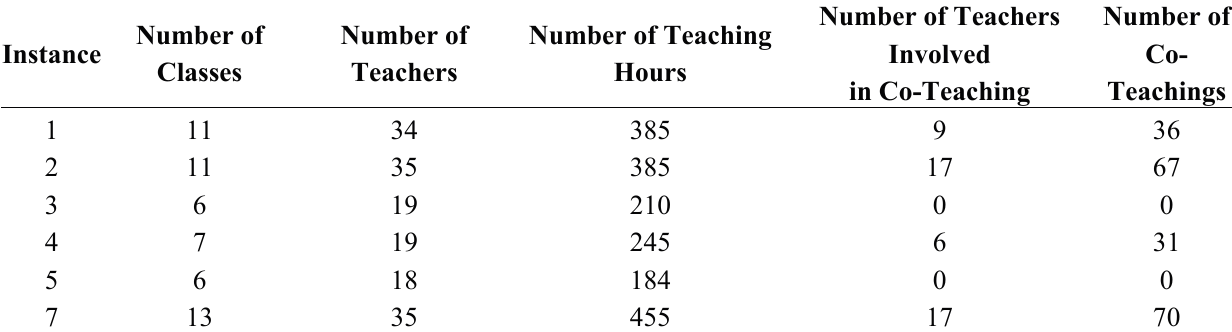
Table 2. Major characteristics of the Beligiannis school timetabling data